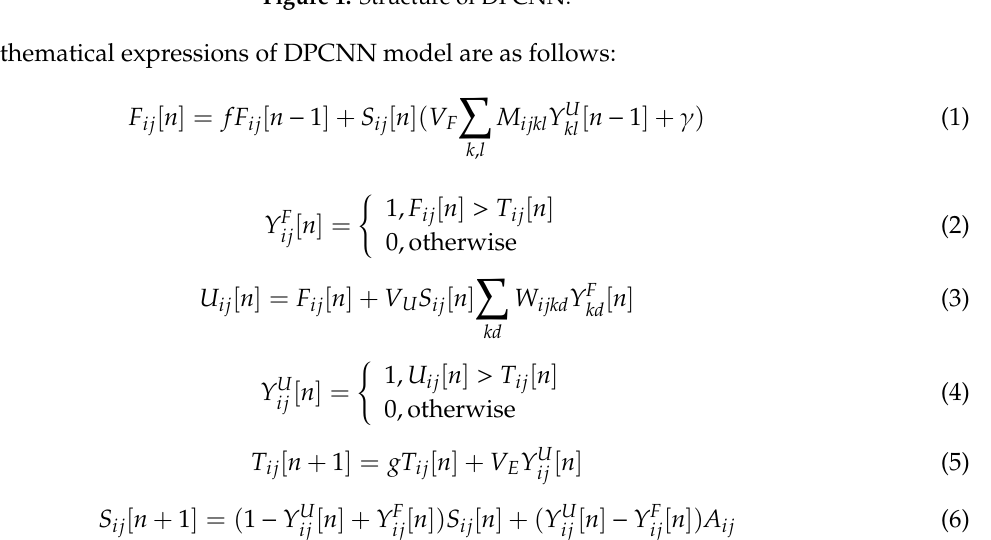
Figure 1. Structure of DPCNN.